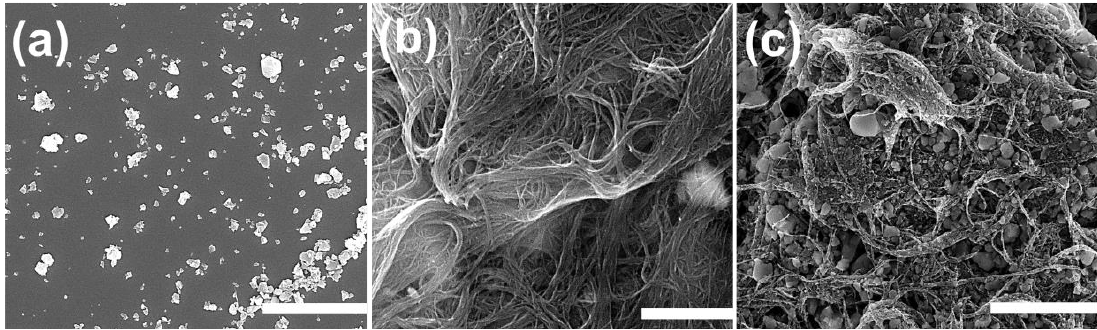
Figure 1. SEM images of ( a ) nano-zeolite-Y particles (NHYZ), scale bar = 3 µ m, ( b ) carbon nanostructure (CNS), scale bar = 1 µ m, and ( c ) NHYZ / CNS, scale bar = 3 µm.